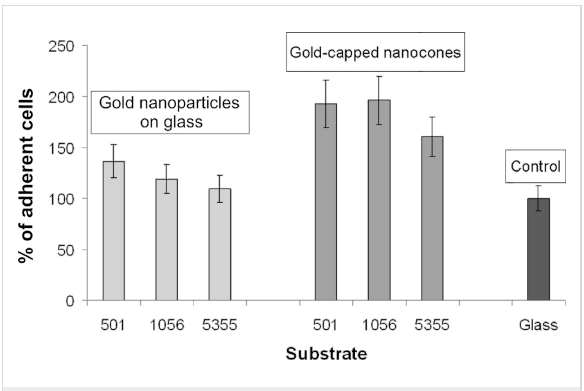
Figure 3: Percentage of adherent cells compared to cell adhesion on control surfaces (glass cover slip coated with laminin, value equals 100%). The nanocone arrays with gold tips show overall higher cell adhesion in comparison to gold nanoparticles on glass or bare glass. Cell adhesion on nanocones is approximately 40% higher compared to flat gold